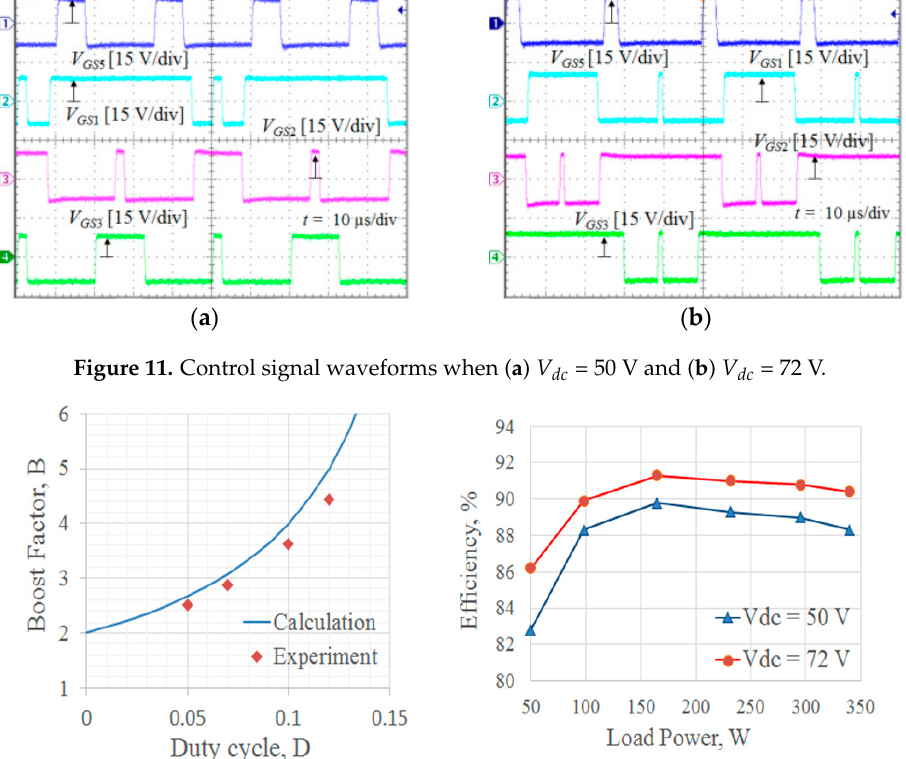
Figure 11. Control signal waveforms when ( a ) V dc = 50 V and ( b ) V dc = 72 V.